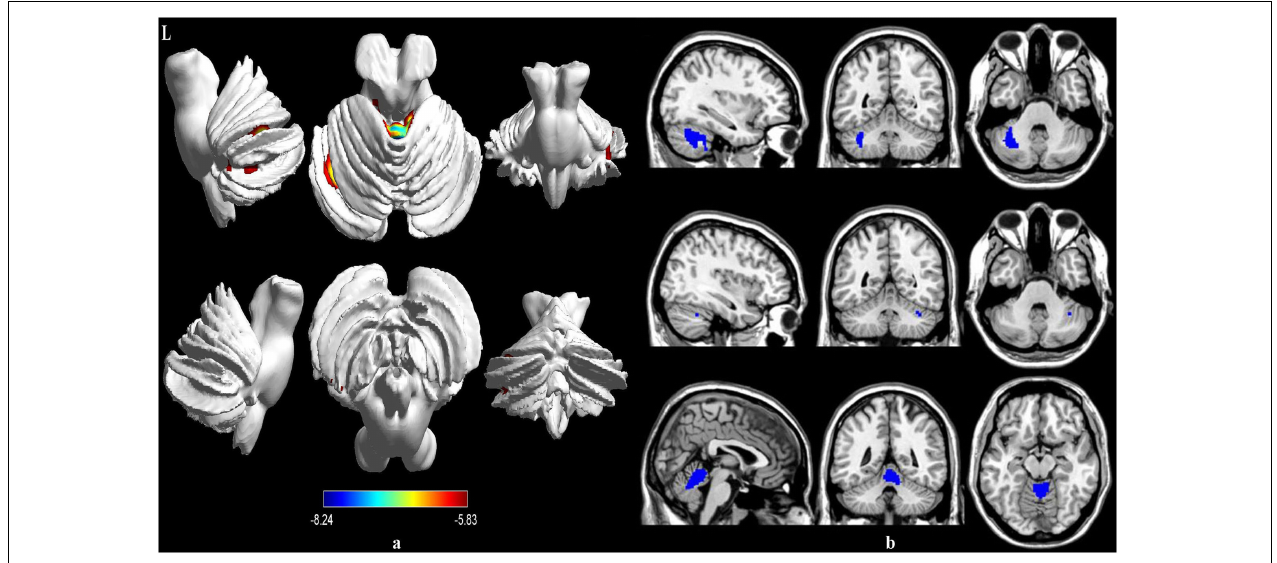
FIGURE 1 | Voxel-wise percentage CBF changes in patients with MSA compared with healthy controls. Decreased rCBF in MSA patients compared to healthy controls were mainly located in the left cerebellum 6, right cerebellum crus 1 and vermis 4,5 (with FEW-corrected P < 0.05). FEW = Family-wise error.